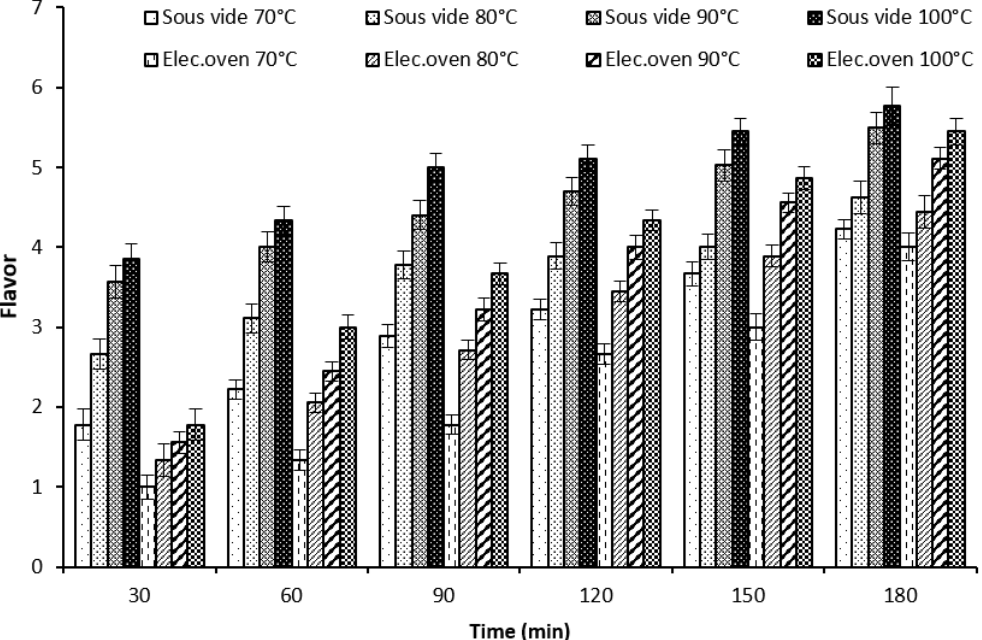
Figure 8. The effect of the cooking method (sous vide vs electrical oven) on the camel meat sensory properties (tenderness) at different combinations of temperature and time.